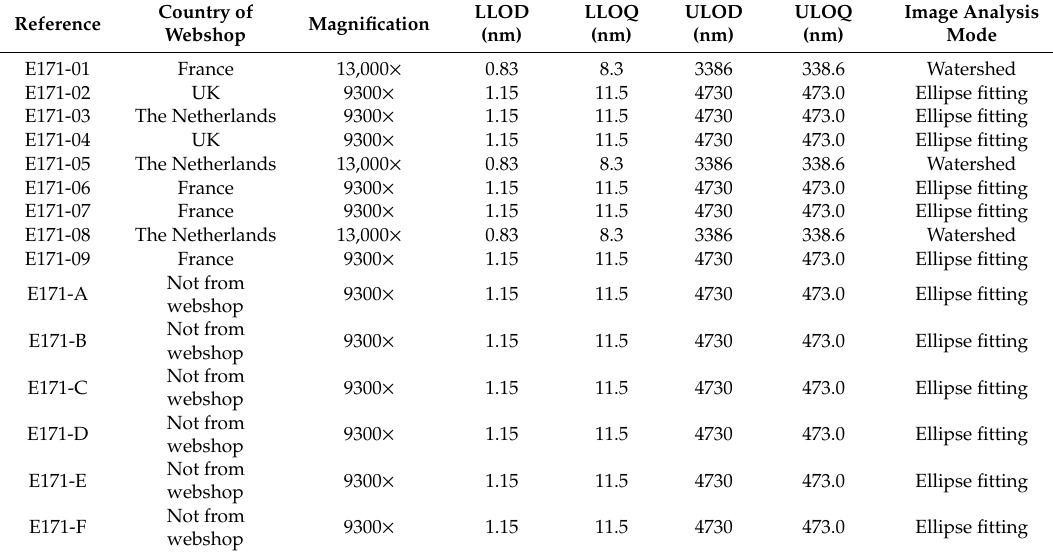
Table 1. Specifications and TEM imaging and image analysis conditions for the E171 materials. LLOD: lower limit of detection, LLOQ: lower limit of quantification, ULOD: upper limit of detection, ULOQ: upper limit of